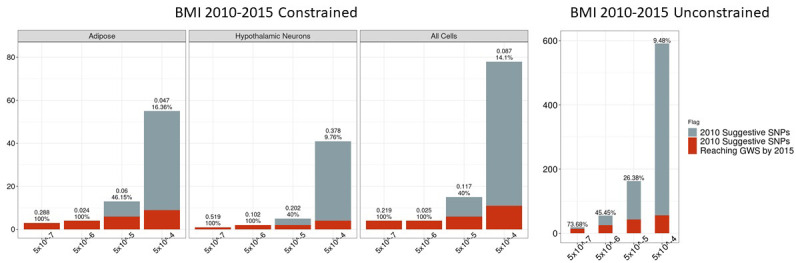
Independent 2010 BMI SNPs identified via variant-to-gene mapping that go on to reach genome-wide significance by 2015, as well as the set of unconstrained 2010 suggestive SNPs that achieve genome-wide significance by 2015.Positive predictive value is depicted as a percentage for each bar. Above these percentages, the p-value, as identified through Fisher’s exact test, is posted. These p-values depict the probability that the proportions of salvaged SNPs using variant-to-gene mapping differ from simply salvaging all suggestive SNPs within the same suggestive bin.Figure 2—source data 1.Number of 2010 loci identified by constrained method and the number that achieved GWS by 2015 in each cell type.Figure 2—source data 2.Number of 2010 loci identified with no constraint and the number that achieved GWS by 2015.